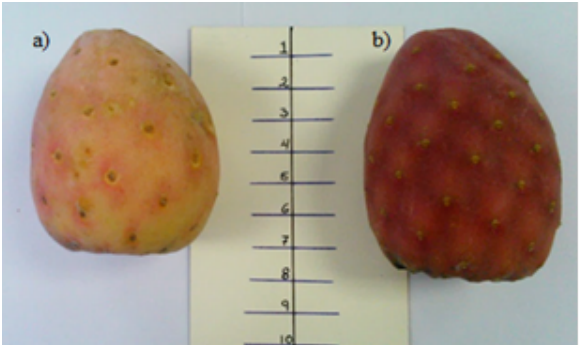
Figure 1. Images of xoconostle fruits: ( a ) Opuntia xoconostle F.A.C. Weber in Diguet cv. Cuaresmeño, ( b ) Opuntia matudae Scheinvar cv. Rosa (scale is in centimeters).